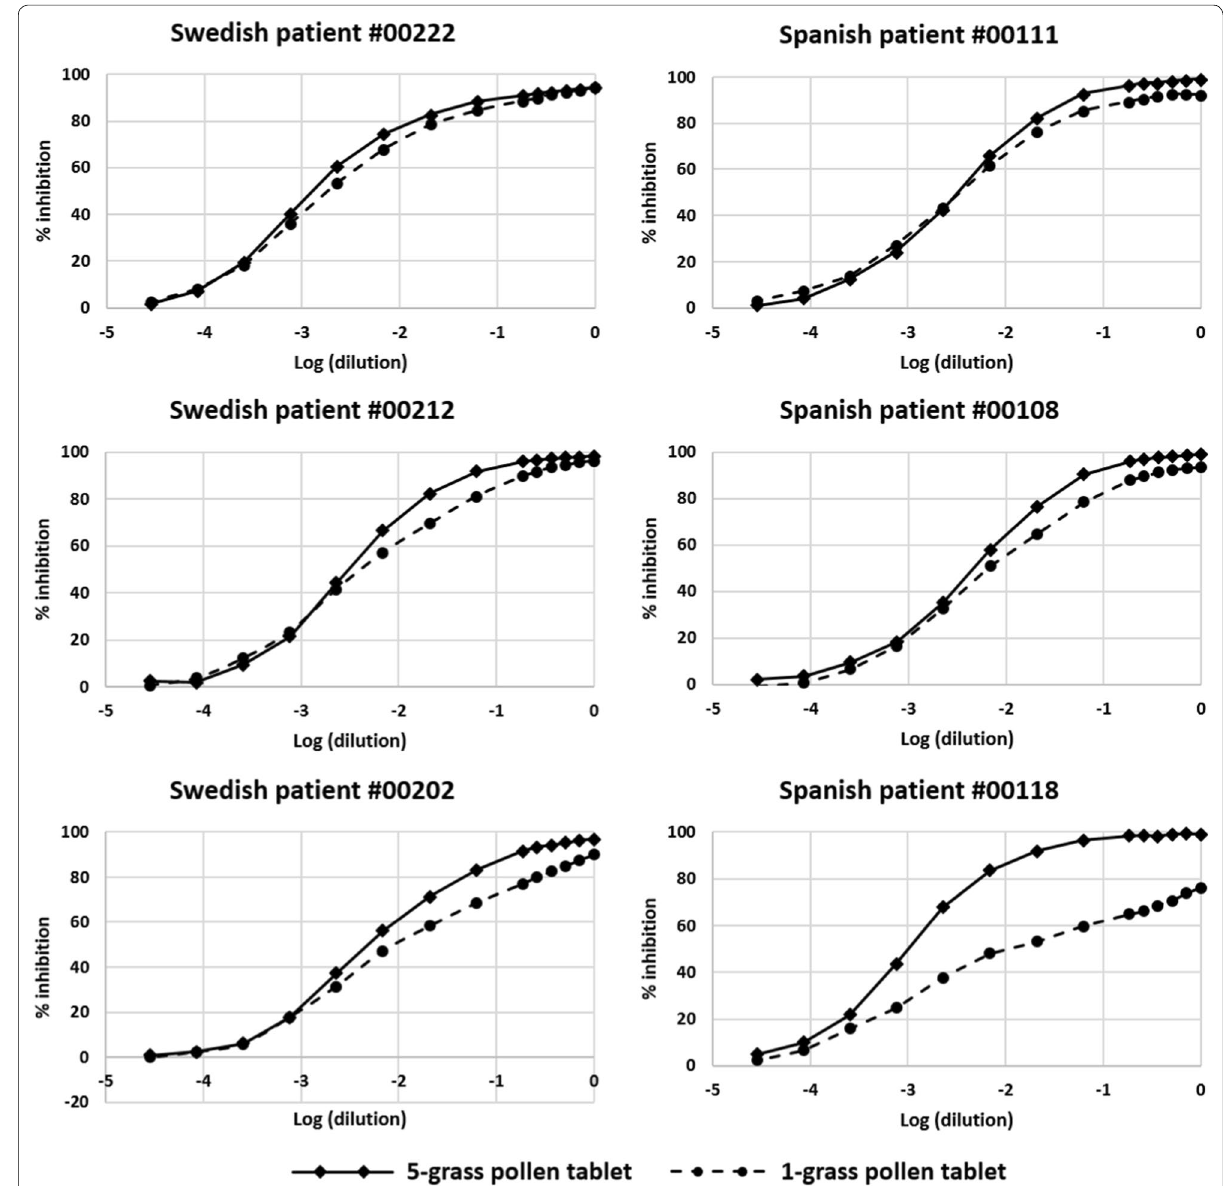
Fig. 1 Inhibition curves corresponding to one tablet of 5-grass pollen extract (plain lines and losanges) and three tablets of 1-grass pollen extract (dashed lines and plain circles). Increasing dilutions of tablets were allowed to compete with immobilized 12-grass pollen allergens for the binding of serum IgE from a grass pollen-allergic patient, and the IgE that remained bound to the immobilized allergens were detected. Patients were classified in 3 tertiles, according to the difference between the AUC obtained with the 5-grass pollen tablet and the one obtained with three 1-grass pollen tablets. Patients of the first, second and third tertiles are exemplified, respectively, by Swedish patient #00222 and Spanish patient #00111 (top), Swedish patient #00212 and Spanish patient #00108 (middle), and Swedish patient #00202 and Spanish patient #00118